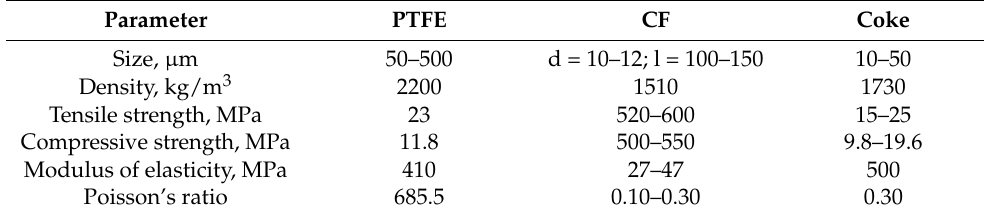
Table 1. Physical and mechanical properties of materials for